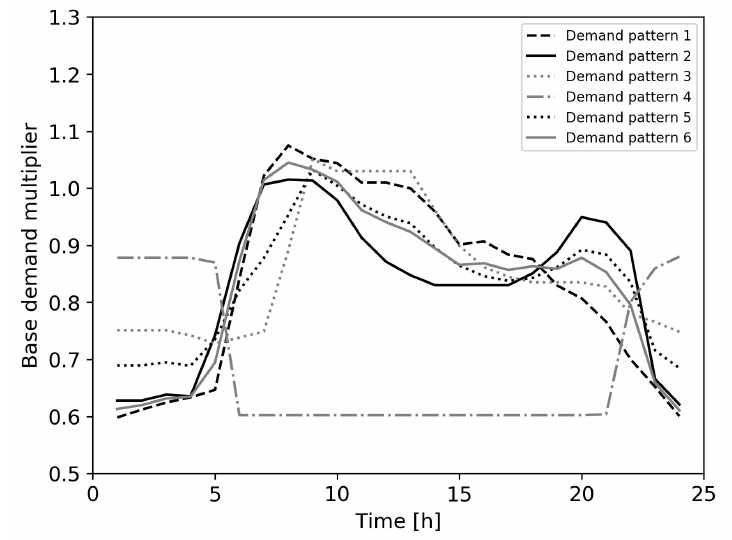
Figure 1. Hanoi network pattern demands.